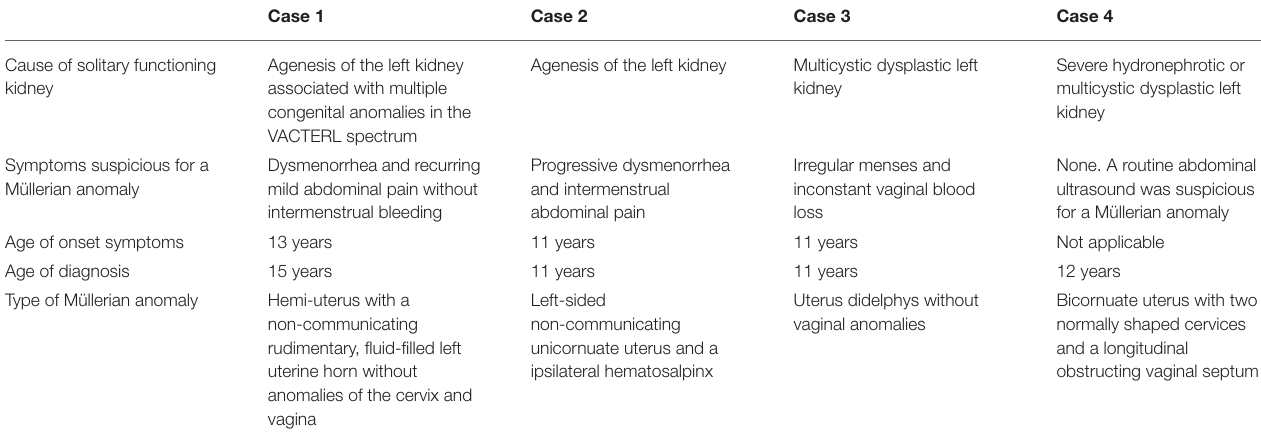
TABLE 3 | Summary of the four described